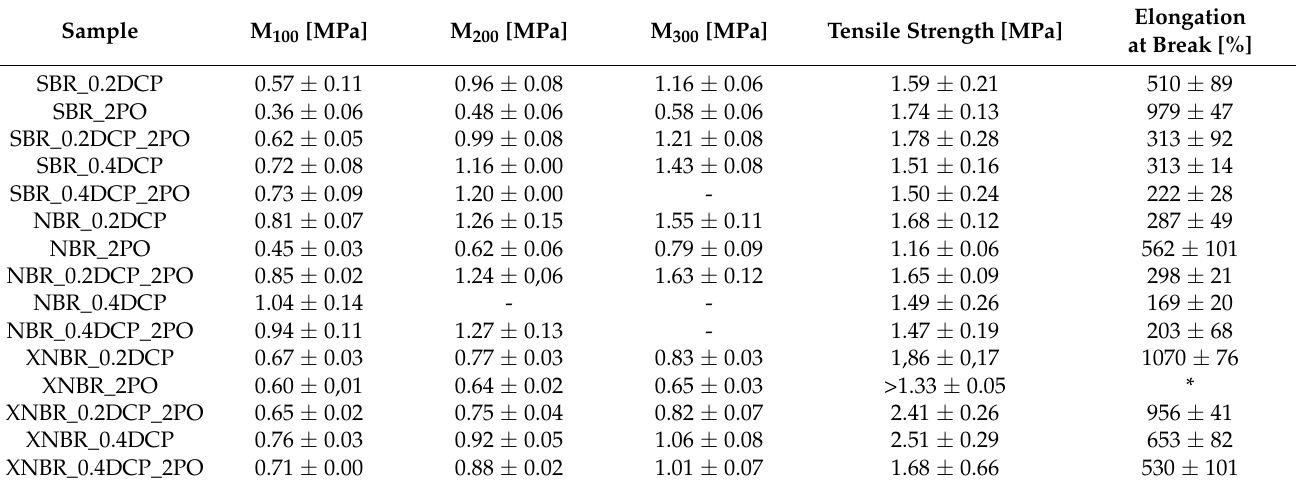
Table 3. Mechanical properties of the rubber samples tested under elongation.